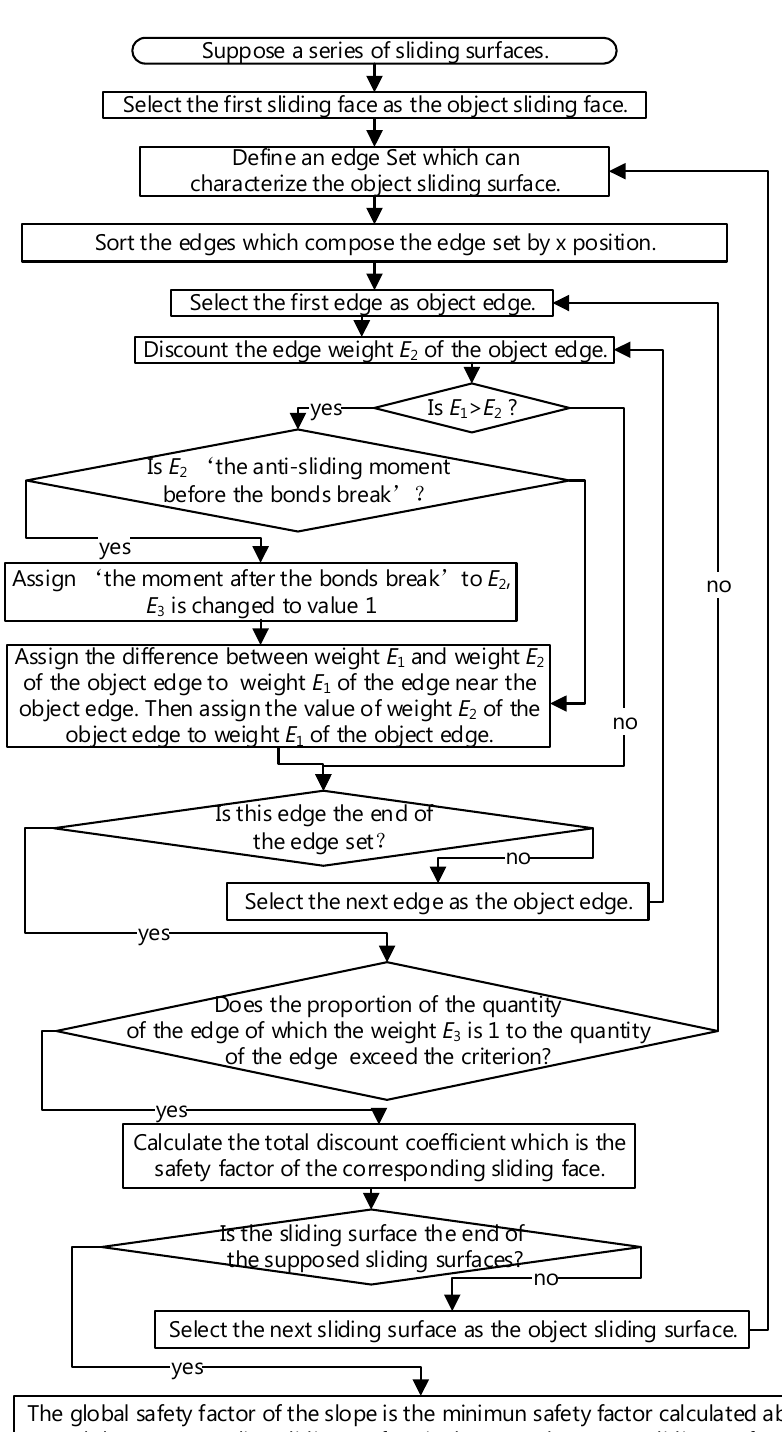
Figure 6. The progress of computing the cohesive soil slope stability.